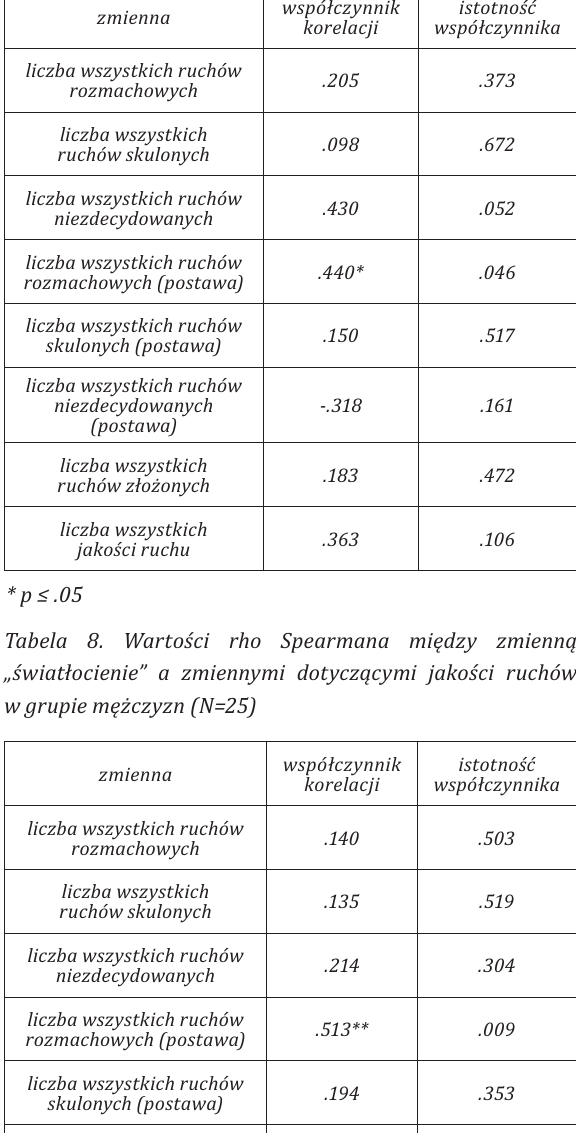
Jak wskazują dane zawarte w Tabeli 6., chore